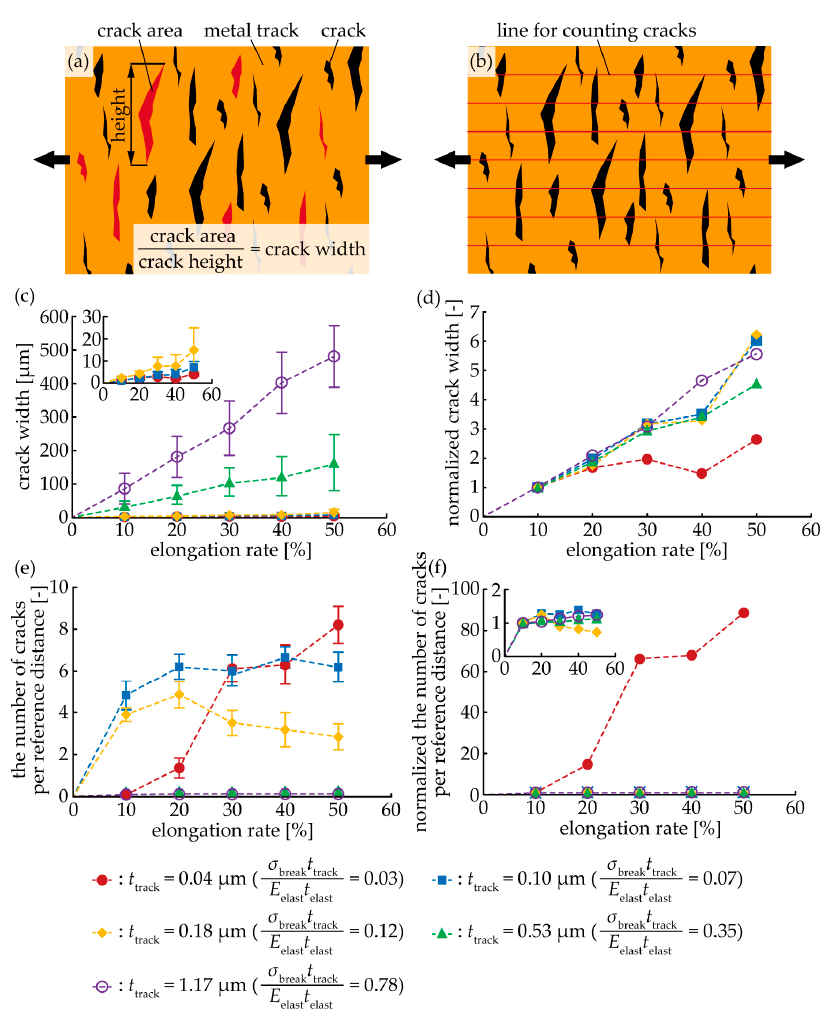
Figure 6. Schematic of the ( a ) measurement of the crack width and ( b ) number of cracks. Relationship between the ( c ) crack width and elongation rate; ( d ) normalized crack width and elongation rate; ( e ) number of cracks and elongation rate; and, ( f ) normalized number of cracks and elongation rate. The reference distance was 100 μ m for an elongation of 0%.